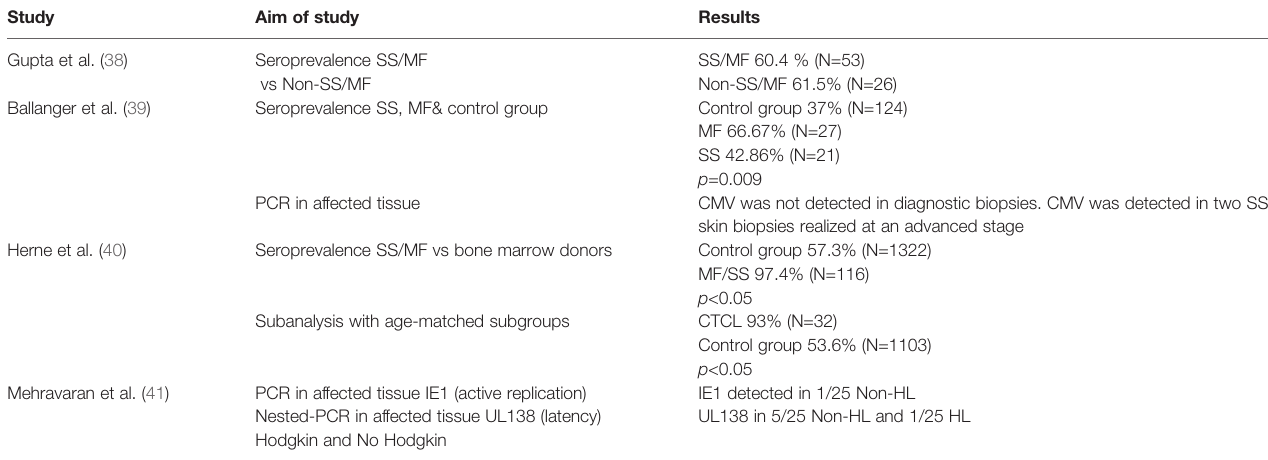
TABLE 1 | CMV role in lymphoma